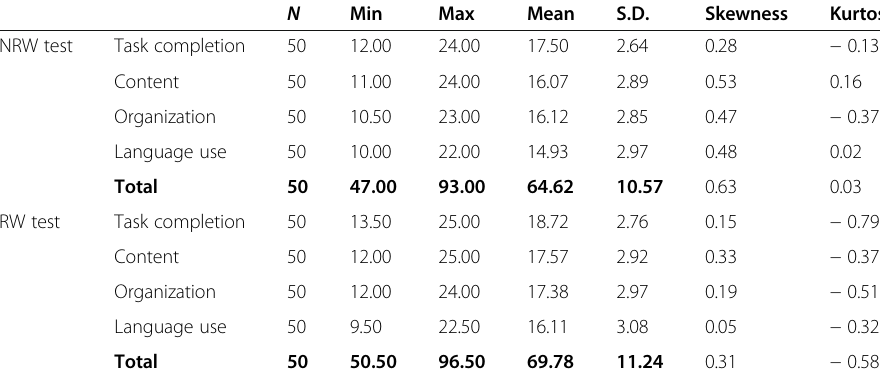
Table 2 Descriptive statistics of test scores